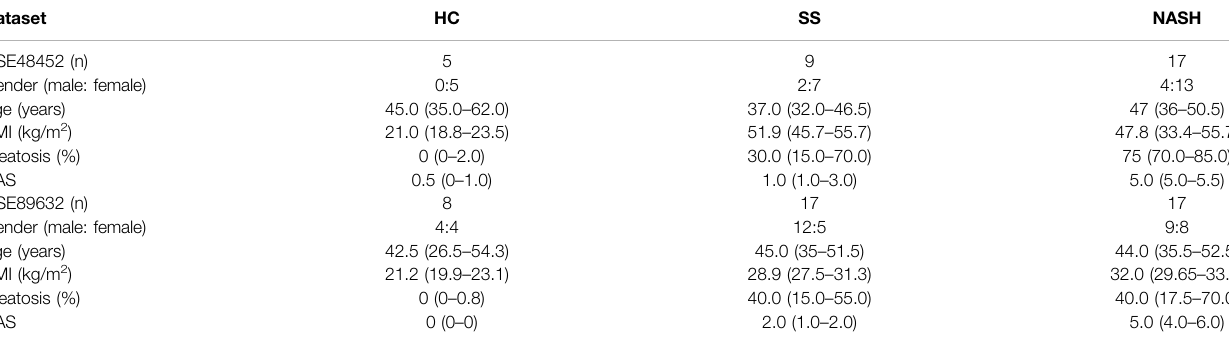
TABLE 1 | The data are shown as median (interquartile range, IQR). HC, healthy control; SS, simple steatosis; NASH, nonalcoholic steatohepatitis; BMI, body mass index; NAS, NAFLD activity score.